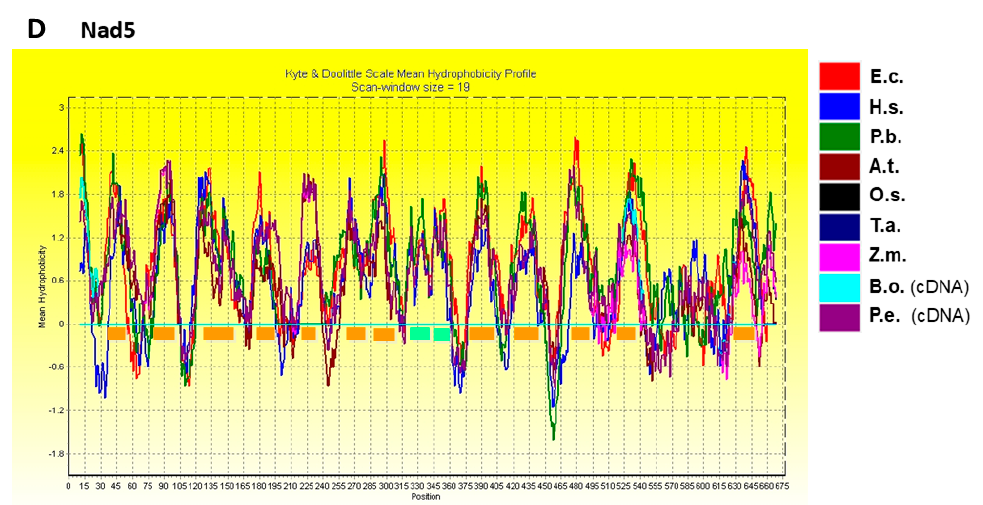
Figure 2. Hydropathy plots of bamboo Nad1, Nad2, Nad4, and Nad5 subunits compared to their homologous proteins in other species. B. oldhamii and P. edulis mitochondrial Nad1 ( A ), Nad2 ( B ), Nad4 ( C ), and Nad5 ( D ) were compared with E. coli (E.c.; BAA16110, BAA16113, BAA16105, and BAA16106), H. sapiens (H.s.; AAB58943, AAB58944, AAB58952, and AAB58953), P. brasiliensis (P.b.; AAY30326, AAY30327, AAY30329, and AAY30339), A. thaliana (A.t.; CAA69811, CAA69771, CAA69742, and CAA69752), O. sativa (O.s.; AAZ99270, AAZ99285, AAZ99271, and AAZ99286), T. aestivum (T.a.; BAE47688, BAE47677, BAE47673, and BAE47687), and Z. mays (Z.m.; AAR91201, AAR91195, AAR91196, and AAR91197). The accession numbers of Nad1, Nad2, Nad4, and Nad5 were obtained from the NCBI database as described in Figure 1. The horizontal thick lines in orange indicate the α -helices and transmembrane domains.